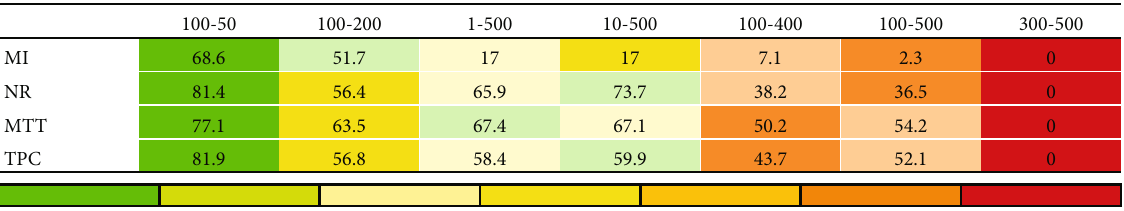
Figure 4: The binary mixtures were sorted according to the response ’ s toxicity at 24 hours according to the four quantitative parameters. The green-red color gradient indicates the magnitude of the e ff ect from the least to most